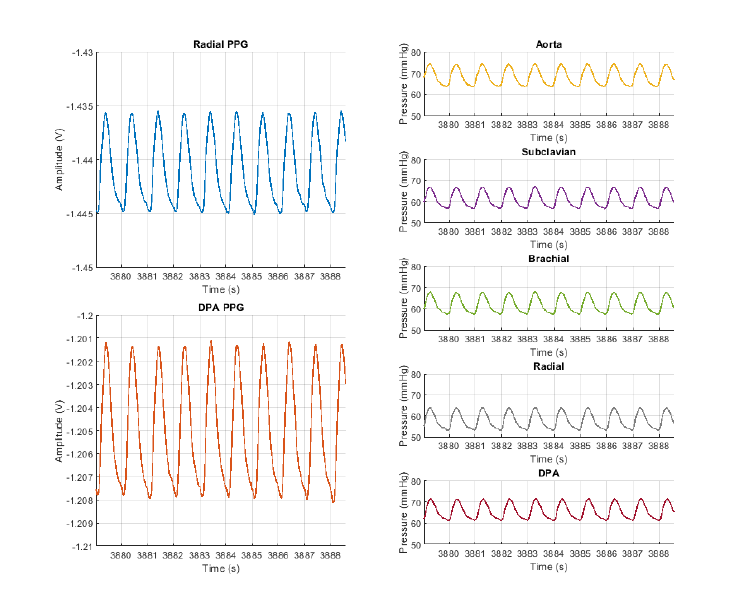
Figure A2. Pressure and photoplethysmographic (PPG) signals acquired from the constructed rig when stroke rate was set to 60 beats per minute and target flow was set to 3 L/min. DPA: Deep palmar